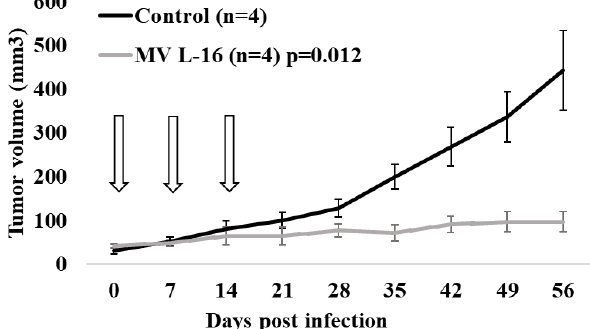
Figure 12. Oncolytic activity of MV strain L-16 against mel Z xenograft tumors in vivo. Mean tumor volume in Balb/c nu/nu mice after three doses of MV L-16 intertumoral injection (n = 4, light grey line) or culture medium ( n = 4, dark line). The error bars indicate the standard deviation of the mean for each group of animals.